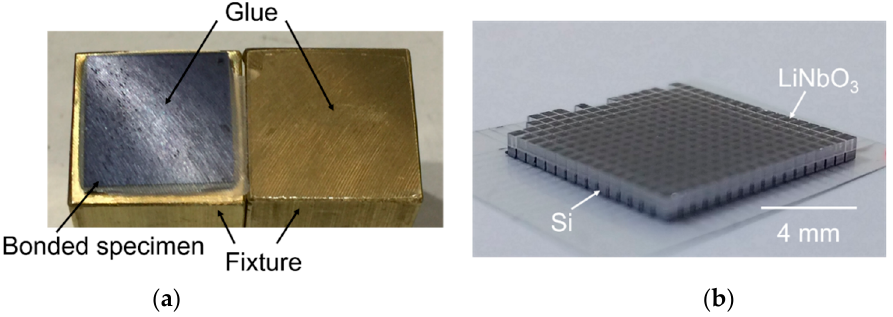
Figure 1. ( a ) Schematic diagram of modified surface activation process. ( b ) Schematic illustration of measurement of stress in bonded lithium niobate (LN) film layer. Figure 2. ( a ) Image of the bonded specimen fracture during tensile test. ( b ) Image of the diced 0.5 mm × 0.5 mm chips.